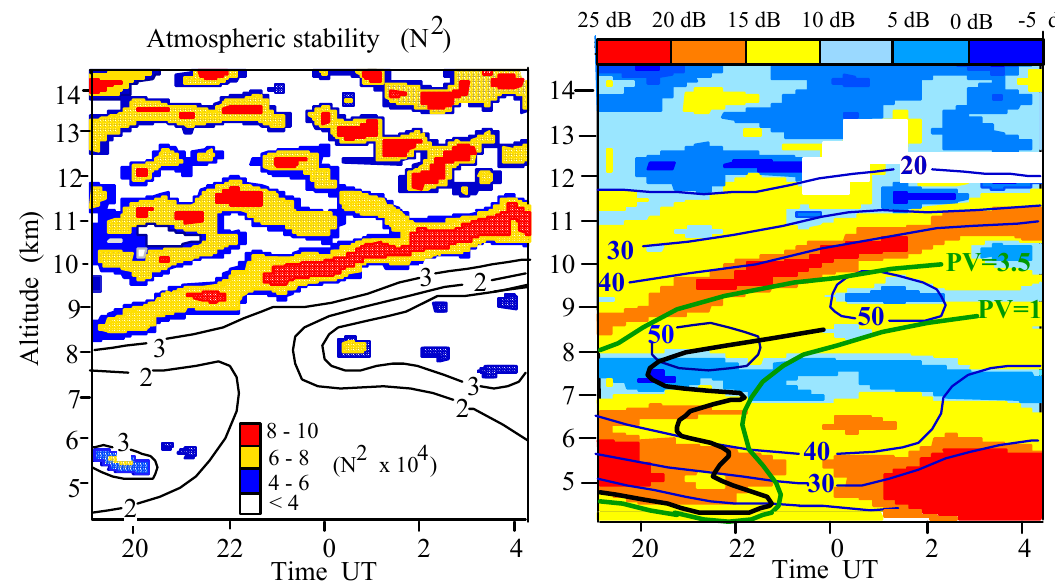
Fig. 5. Time-height cross section of: (a) the atmospheric stability N 2 (s − 2 ) deduced from the temperature field measured by the OHP Raman lidar, and (b) the signal-to-noise ratio (in dB) measured along the vertical by the OHP VHF radar. Also drawn for comparison is the observed wind field (in blue), the 60 ppm ozone iso-line, measured by the ozone lidar (in black), and in green, the potential vorticity iso- lines PV = 1 (as a tracer of the fold) and PV = 3 . 5 · 10 − 6 m 2 s − 1 K kg − 1 (as a tracer of the thermal tropopause) deducted from the ECMWF